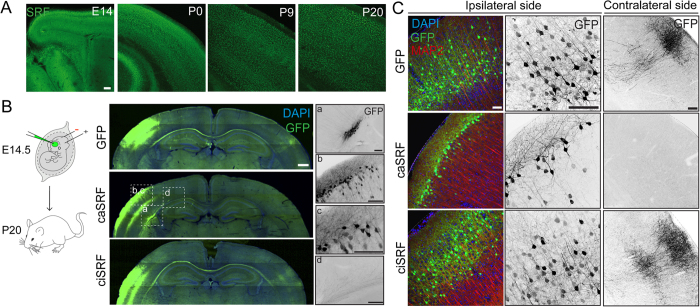
Enhanced SRF activity causes aberrant cell positioning and arborization in the developing cortex.(A) Immunostaining against SRF indicates that SRF is expressed during cortex development. Scale bar: 100 μm. (B) Left panel: Scheme of the in utero electroporation experiment. Center panels: composite images of coronal brain sections of P20 mice electroporated at E14.5 with GFP alone (GFP) or in combination with caSRF or ciSRF. Brain slices were stained with anti-GFP antibody and counterstained with DAPI. Scale bar: 500 μm. Right panels: Four phenotypes associated with caSRF expression: (a) impaired migration of some neurons to the cortical layers. (b) aberrant layer positioning, (c) misoriented apical dendrite, (d) axon mistargeting along corpus callosum. Scale bar: 100 μm. (C) Left panels: Higher magnification images of electroporated neurons at the ipsilateral side after triple staining with DAPI (DNA counterstaining), anti-GFP and anti-MAP2 (neuronal dendritic marker). Central and right panels: Detail of GFP staining at the ipsi- and contralateral sides. Scale bar: 100 μm.